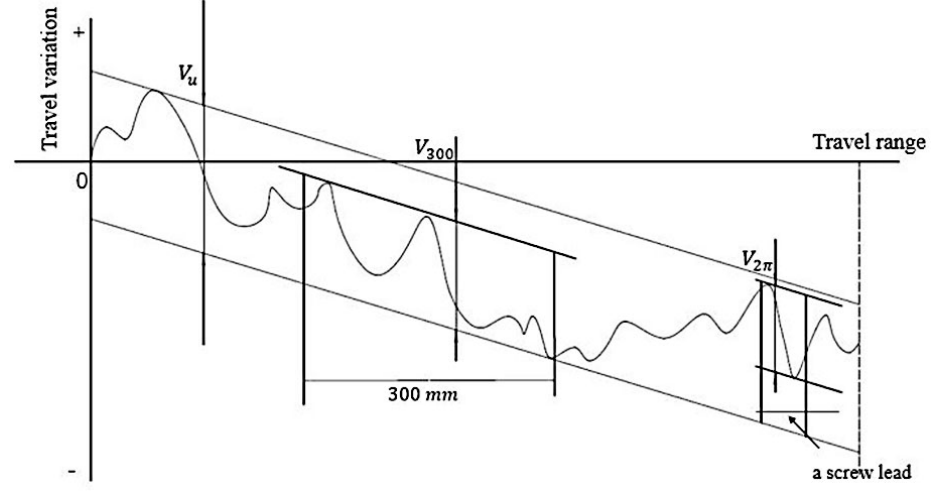
Figure 7. Travel variation indices.